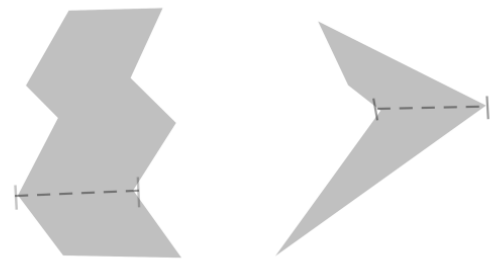
Figure 7. Effect of concave surface on sieving.